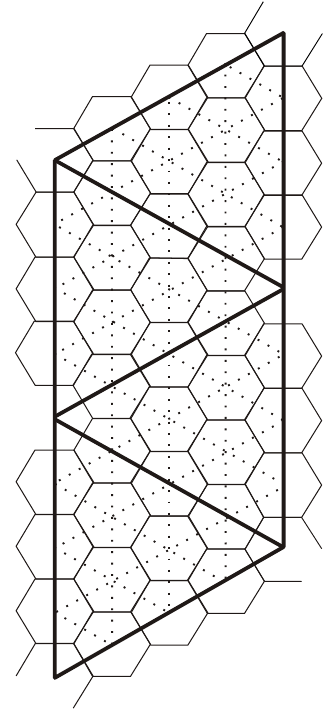
Figure 2. Four triangles of an icosahedron are surrounded by thick, bold lines. Vertices of the bold triangles are centers of incomplete pentagonal primary cells. Edges of primary cells, for grid level 2, are indicated by thin solid lines. Dotted lines, between primary cell centers, indicate edges of triangular momentum cells. Primary cell corners are momentum cell